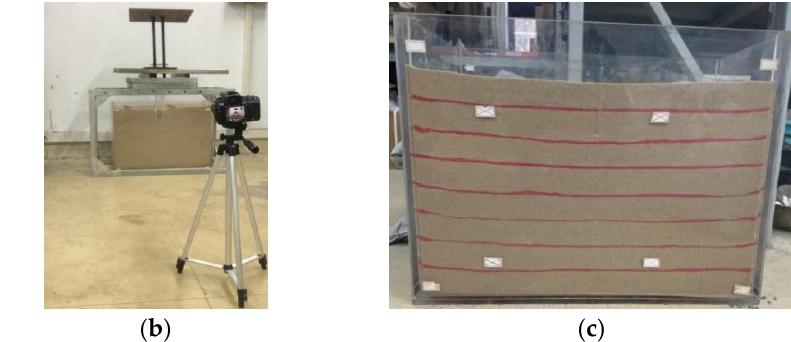
Figure 8. Experiment and schematic diagram, showing the ( a ) schematic diagram of model design, ( b ) laboratory test site, and ( c ) model box with stained sand. ( b ) laboratory test site, and ( c ) model box with stained sand.